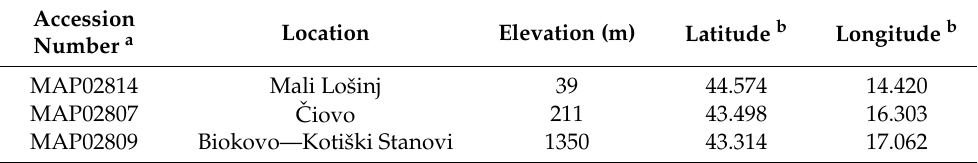
Table 4. Sampling sites of Dalmatian pyrethrum for preliminary genetic diversity